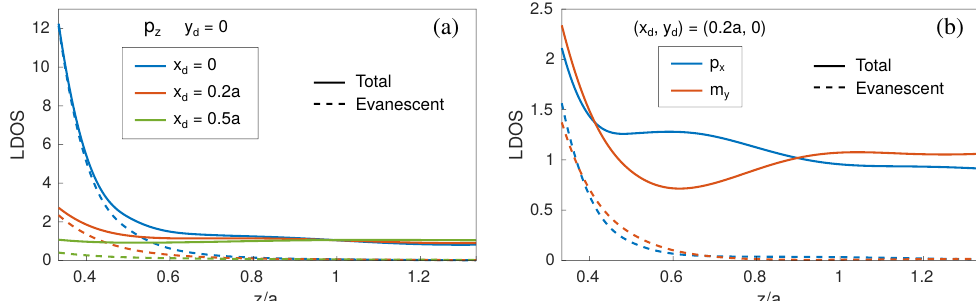
Figure 3. LDOS as a function of the distance from the metasurface plane z d (solid curves) for the Si nanosphere metasurface as in Figure 2, at the wavelength of the symmetry-protected ED-BIC ( λ = 552 nm), including separately the evanescent contributions (dashed curves): ( a ) p z at x d = 0 (blue curves), x d = 80 nm (red curves), and x d = 200 nm (green curves); ( b ) p x (blue curves) and m y (red curves) at x d = 80 nm; all for y d = 0.